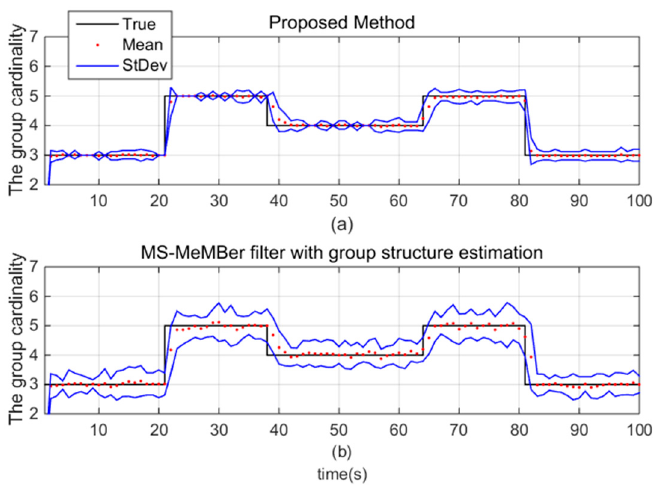
Figure 10. The estimated group cardinality for ( a ) the proposed method and ( b ) the MS-MeMBer filter with group structure estimation. Table 2. Average running time.